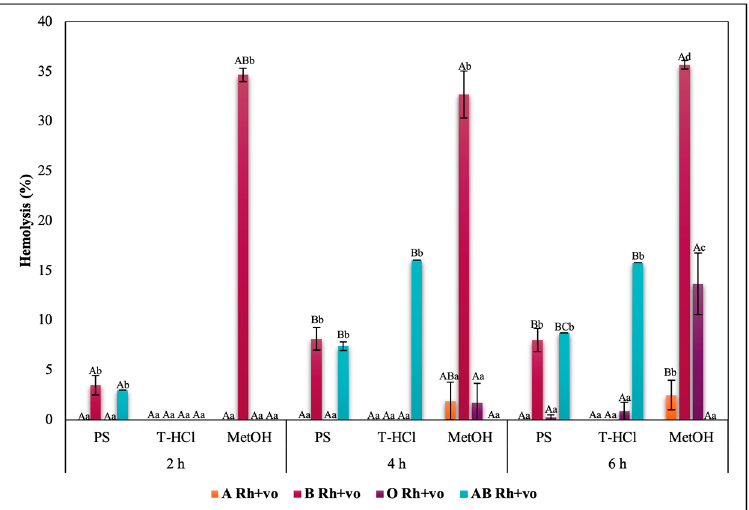
Figure 5. Blood biocompatibility assay of P. cruentum extracts on human erythrocytes with different ABO blood groups. Different letters represent significant differences in the means between treatments and groups ( p ≤ 0.001). Capital letters represent a two-way ANOVA. Lowercase letters represent a univariate ANOVA between extracts for each exposure period. PS, extract of physiological solution; T-HCl, 0.5 M Tris-HCl extract; MetOH, 99% methanol extract; AA, ascorbic acid; BCT, beta-carotene; FXA, fucoxanthin.